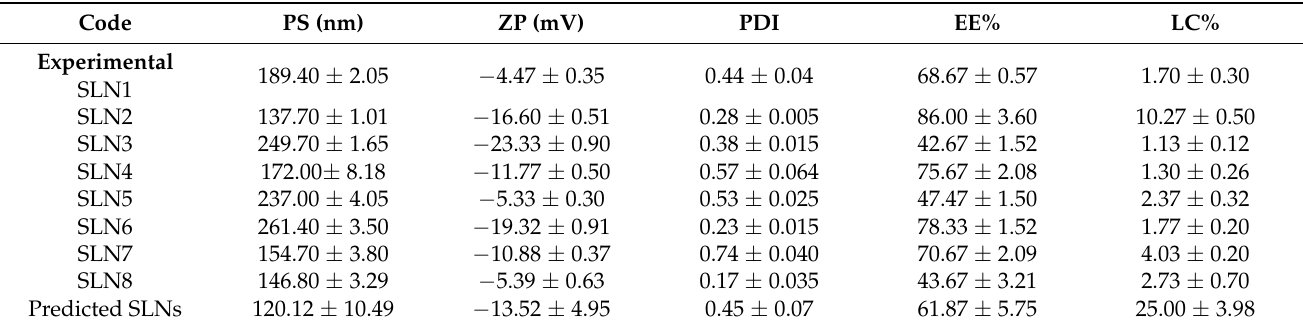
Table 2. SLNs-dependent variables respective to DoE-predicted independent variables.